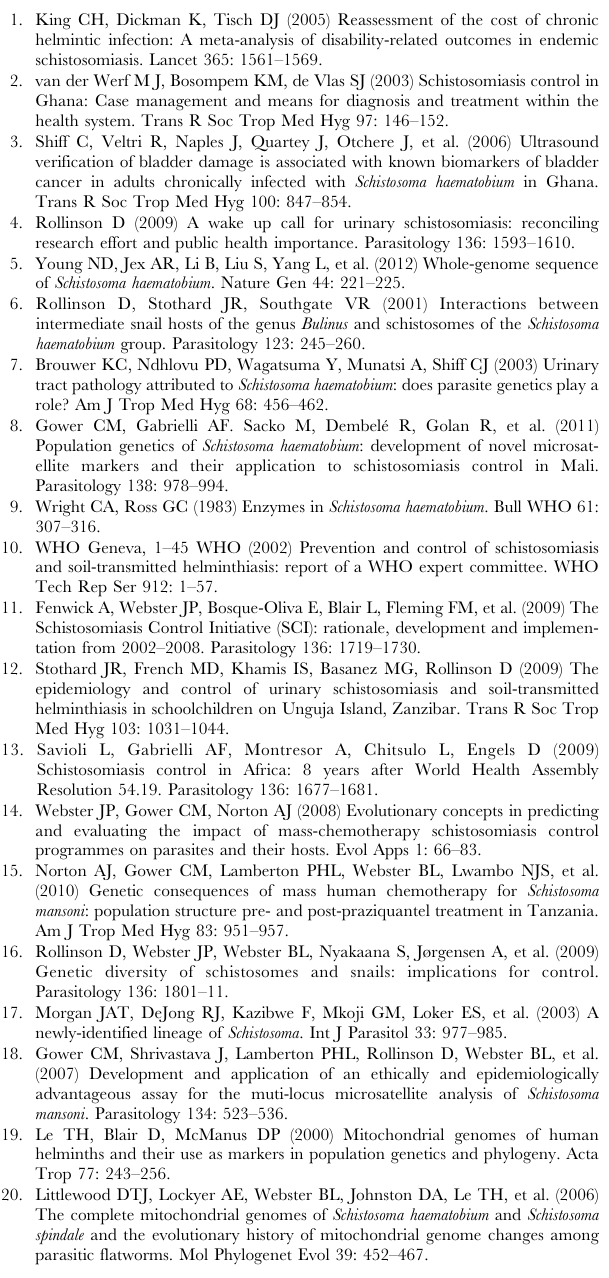
Table S1 Sample and haplotype information (Support- ing